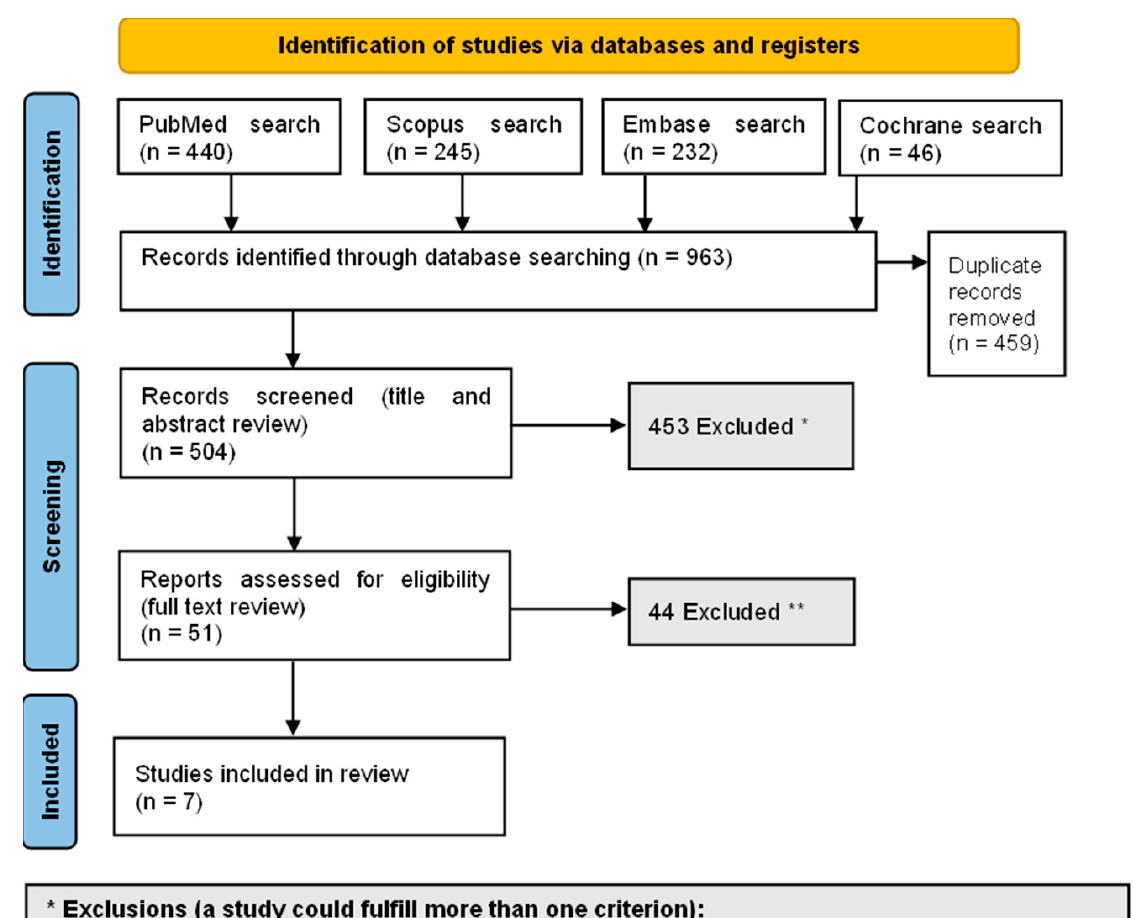
Figure 1. Flow chart of the literature search and the study selection process.